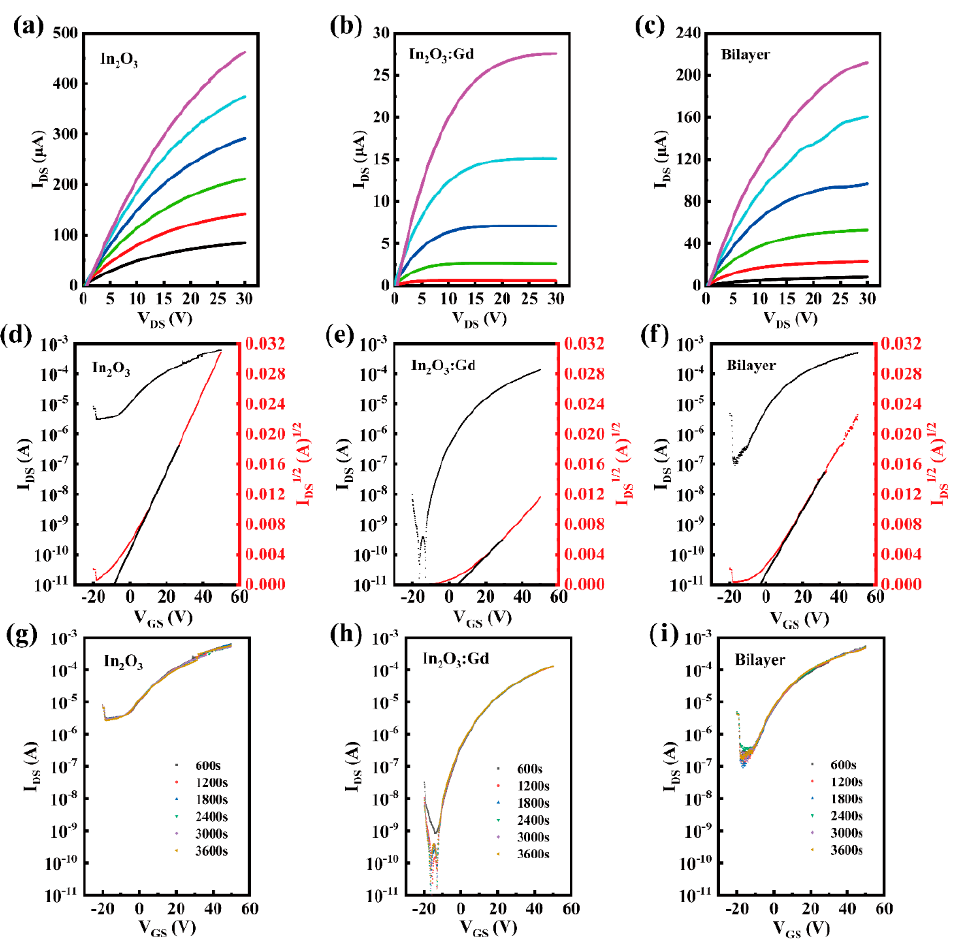
Figure 2. The representative output curves ( a – c ) and transfer curves ( d – f ) and transfer curves under the PBS ( g – i ) of the In 2 O 3 or InGdO single-layer and In 2 O 3 /InGdO heterojunction TFTs at V DS = 10 V. The transfer curves for In 2 O 3 , InGdO, and In 2 O 3 /InGdO TFTs under positive